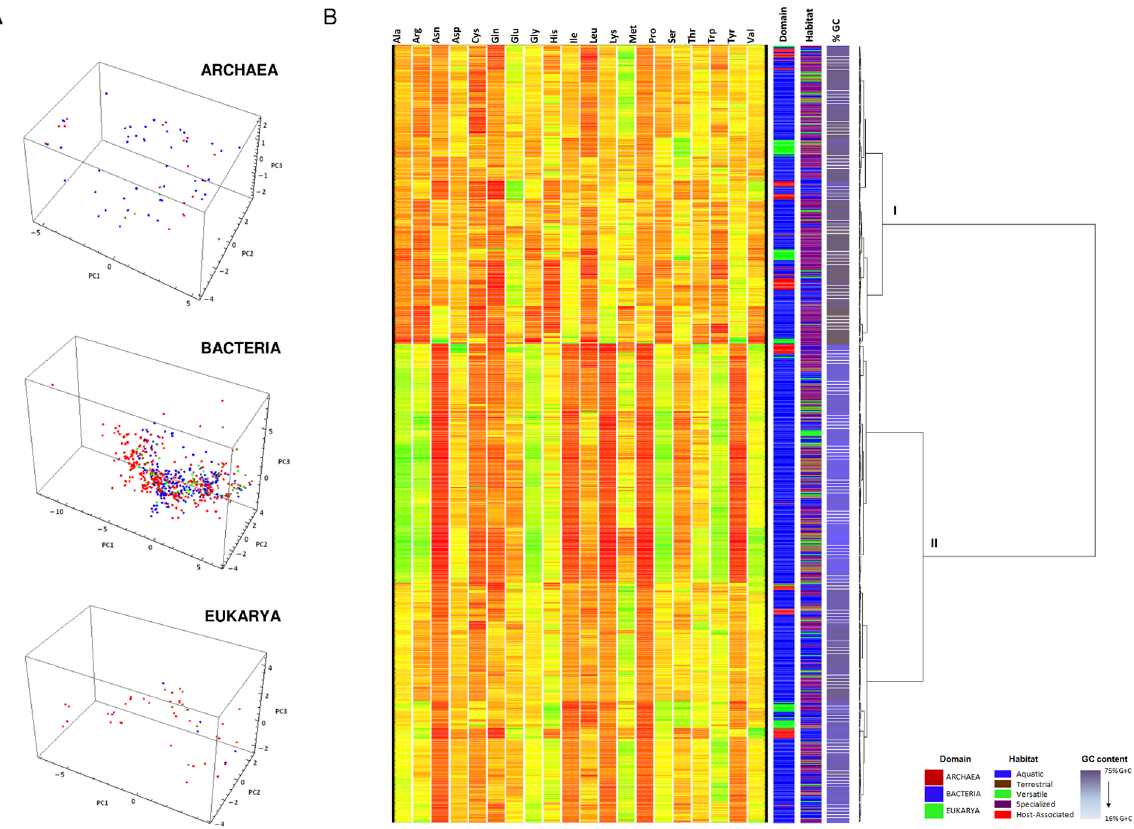
Figure 2. Characterization of the relative amino acid composition of the proteomes from different organisms. A) scatter plot by Principal Component Analysis according to the type of environment; B) Hierarchical clustering analysis. The length of branches represents the degree of dissimilarity between clusters. The x-axis of the heat map represents the 20 amino acids by alphabetical order of the three-letter code name. The y- axis of the heatmap represents the individual organisms where amino acid abundance was estimated. Over- and under-representation of amino acid residues in each organism are represented in green and red colored squares, respectively. doi:10.1371/journal.pone.0077319.g002 PLOS ONE |